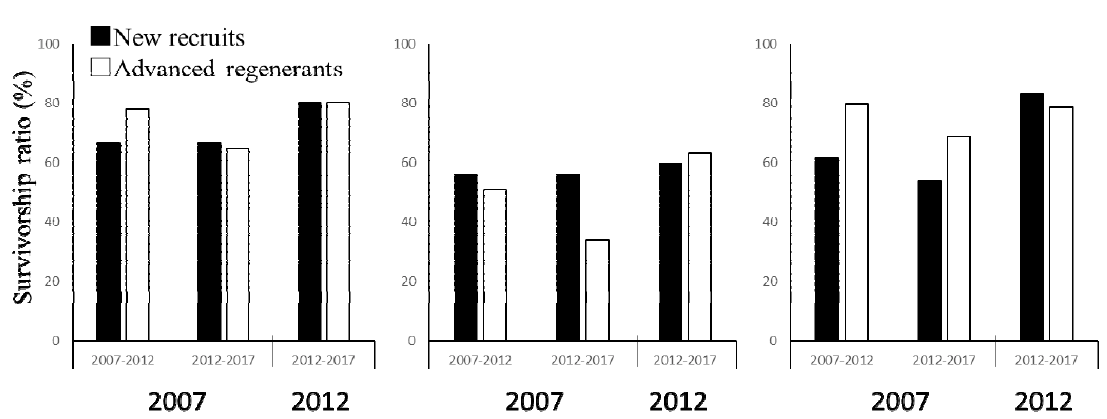
Figure 3. Survivorship ratios of new recruits and advanced regenerants. For saplings living in 2007, the survivorship ratios of new recruits and advanced regenerants of the same size as the new recruits in 2007–2012 and 2012–2017 are shown. For saplings living in 2012, the survivorship ratios of gap successors and advanced regenerants of the same size as the new recruits in 2012–2017 are shown. No differences between new recruits and advanced regenerants were significant.